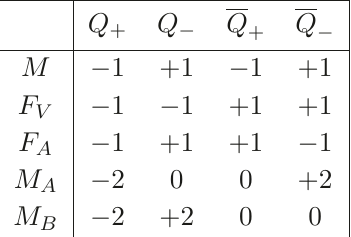
Table 1 . The spin, R-charges and twisted spins of the supercharges in the metry